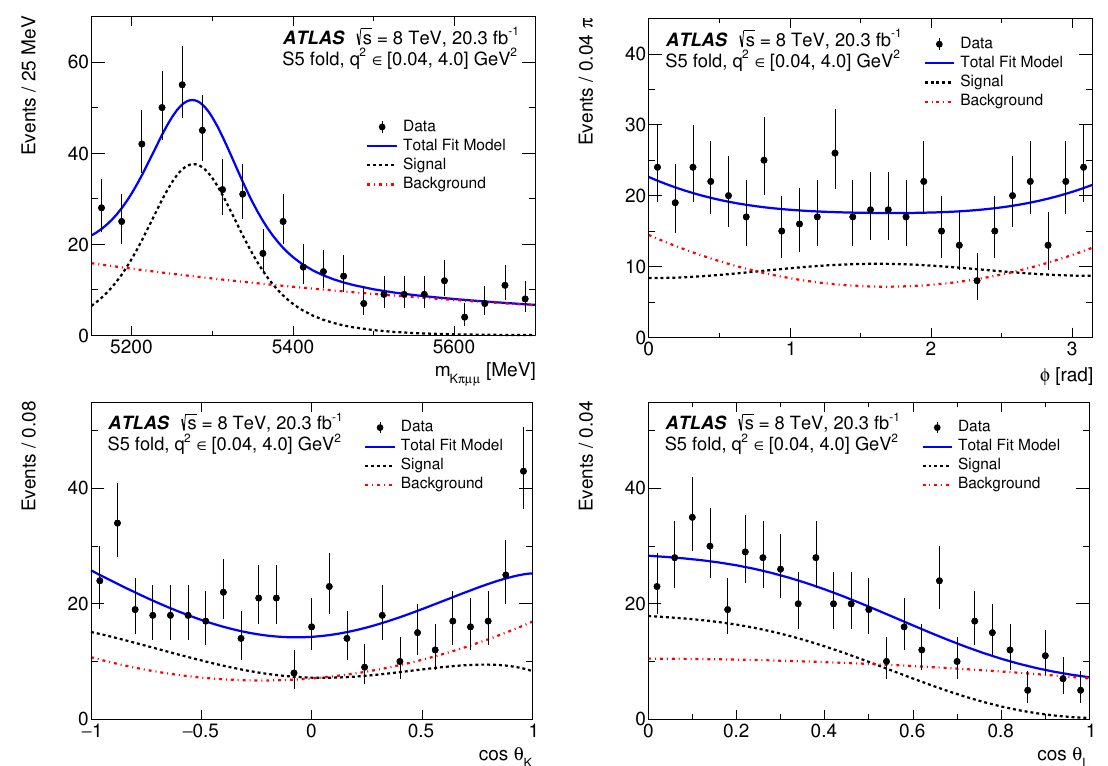
Figure 7 . The distributions of (top left) m , (top right) (cid:30) , (bottom left) cos (cid:18) , and (bottom K(cid:25)(cid:22)(cid:22) K right) cos (cid:18) obtained for q 2 2 [0 : 04 ; 4 : 0] GeV 2 . The (blue) solid line is a projection of the total L pdf, the (red) dot-dashed line represents the background, and the (black) dashed line represents the signal component. These plots are obtained from a (cid:12)t using the S folding 5